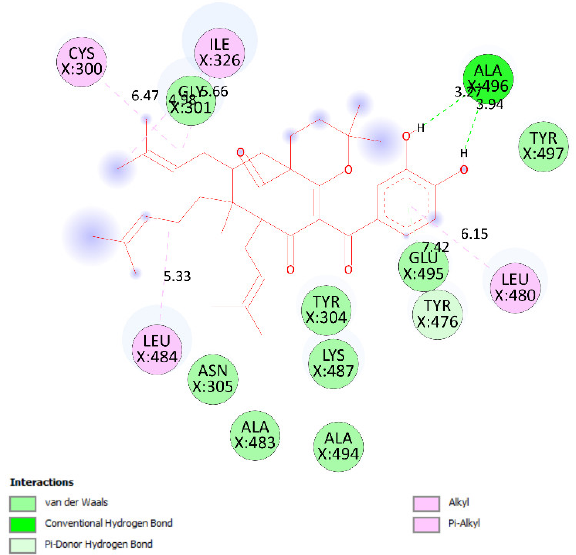
Figure 16. The hydrogen bonds and electrostatic interactions linked from active atoms on pose 158, compound 1 , to active residual amino acids on enzyme 2VF5.